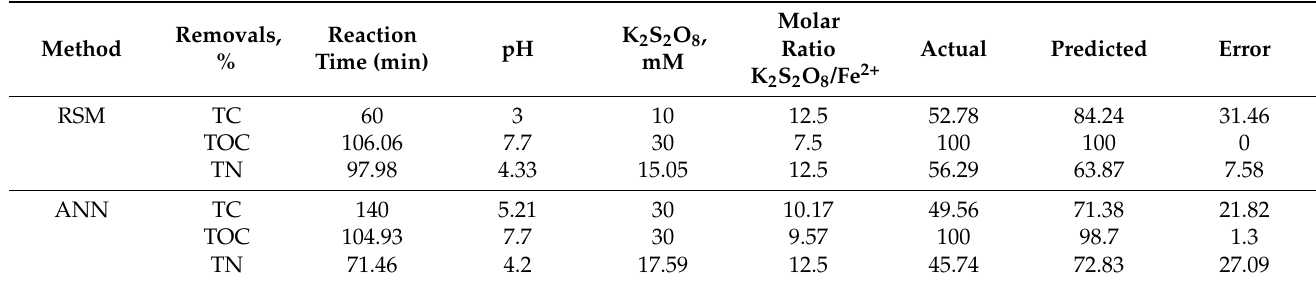
Table 3. Optimum conditions found by RSM and ANN, and experimental validation for TC, TOC, and TN removals.